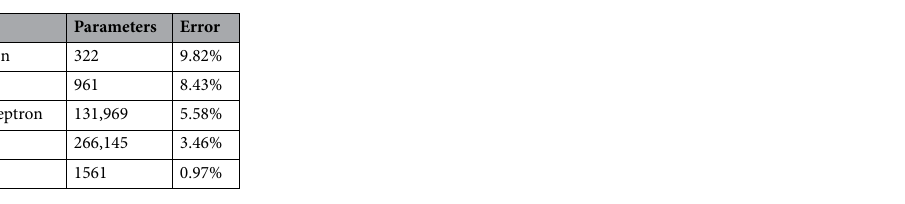
Table 1. Performance benchmarks of different